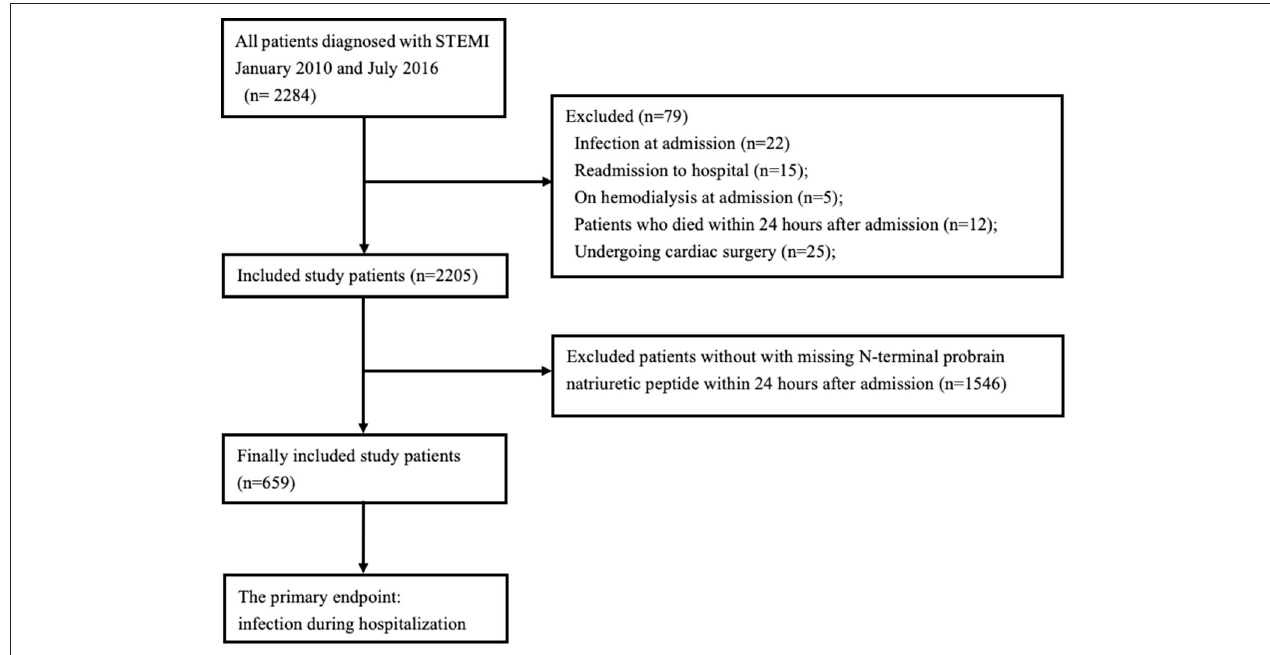
FIGURE 1 | Flow diagram of the